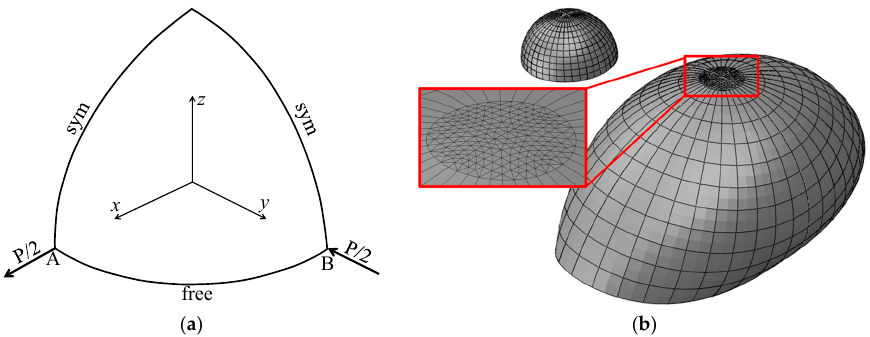
Figure 18. Pinched hemisphere: ( a ) geometry and ( b ) undeformed and deformed configurations. The radius and thickness of the hemispherical shell are R = 10 m and t = 0.04 m, respectively. 0.3 ν= , while the Young modulus of the metal and